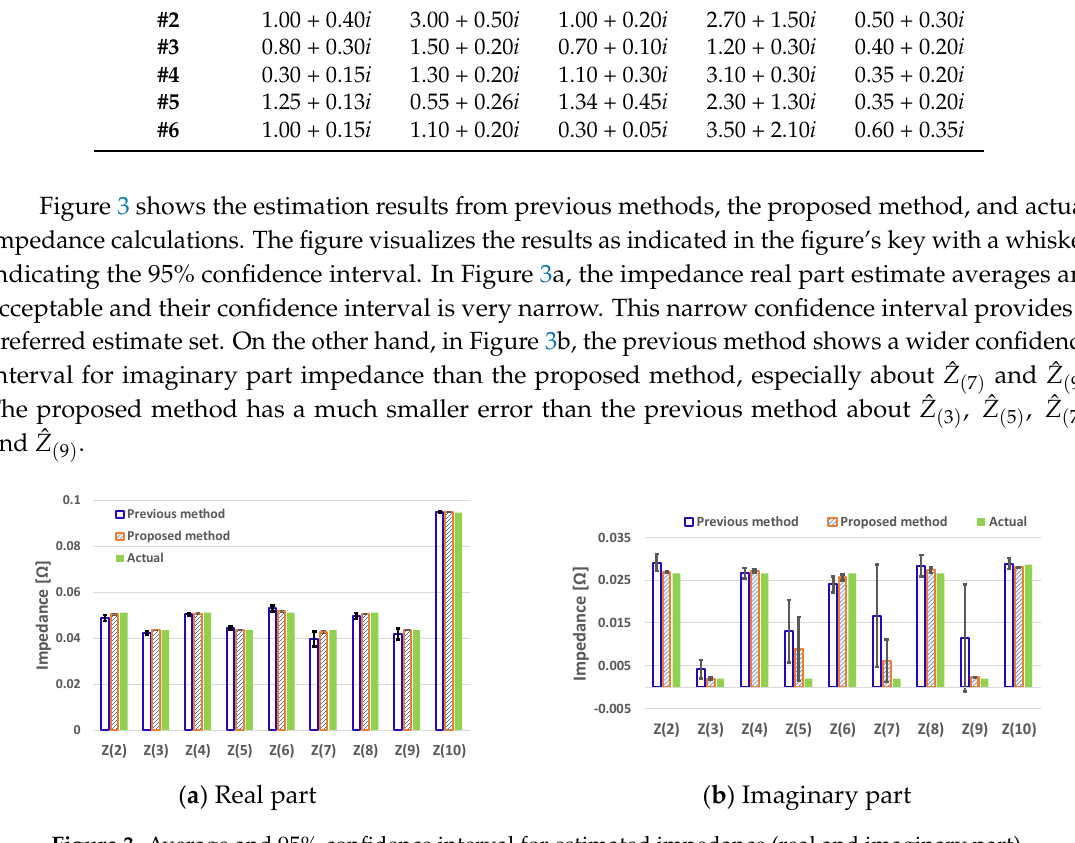
( b ) Imaginary part Figure 4. Average and 95% confidence interval for error of estimated impedance (real and imaginary part).